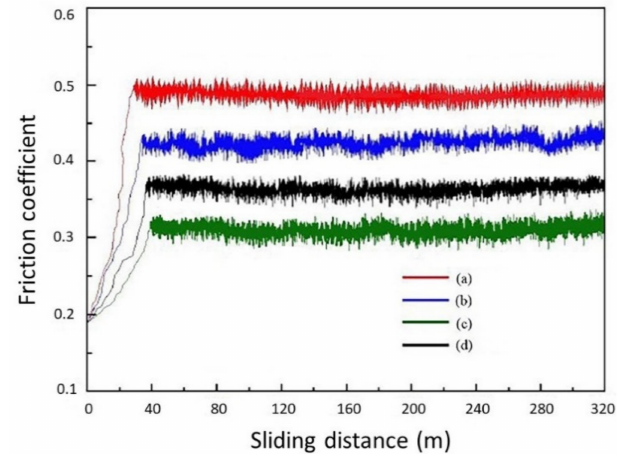
Figure 9. The frictional coefficient of Ni–TiN coatings prepared at various nozzle diameters: ( a ) Nf = Φ 3 mm, ( b ) Nf = Φ 5 mm, ( c ) Nf = Φ 7 mm, ( d ) Nf = Φ 9